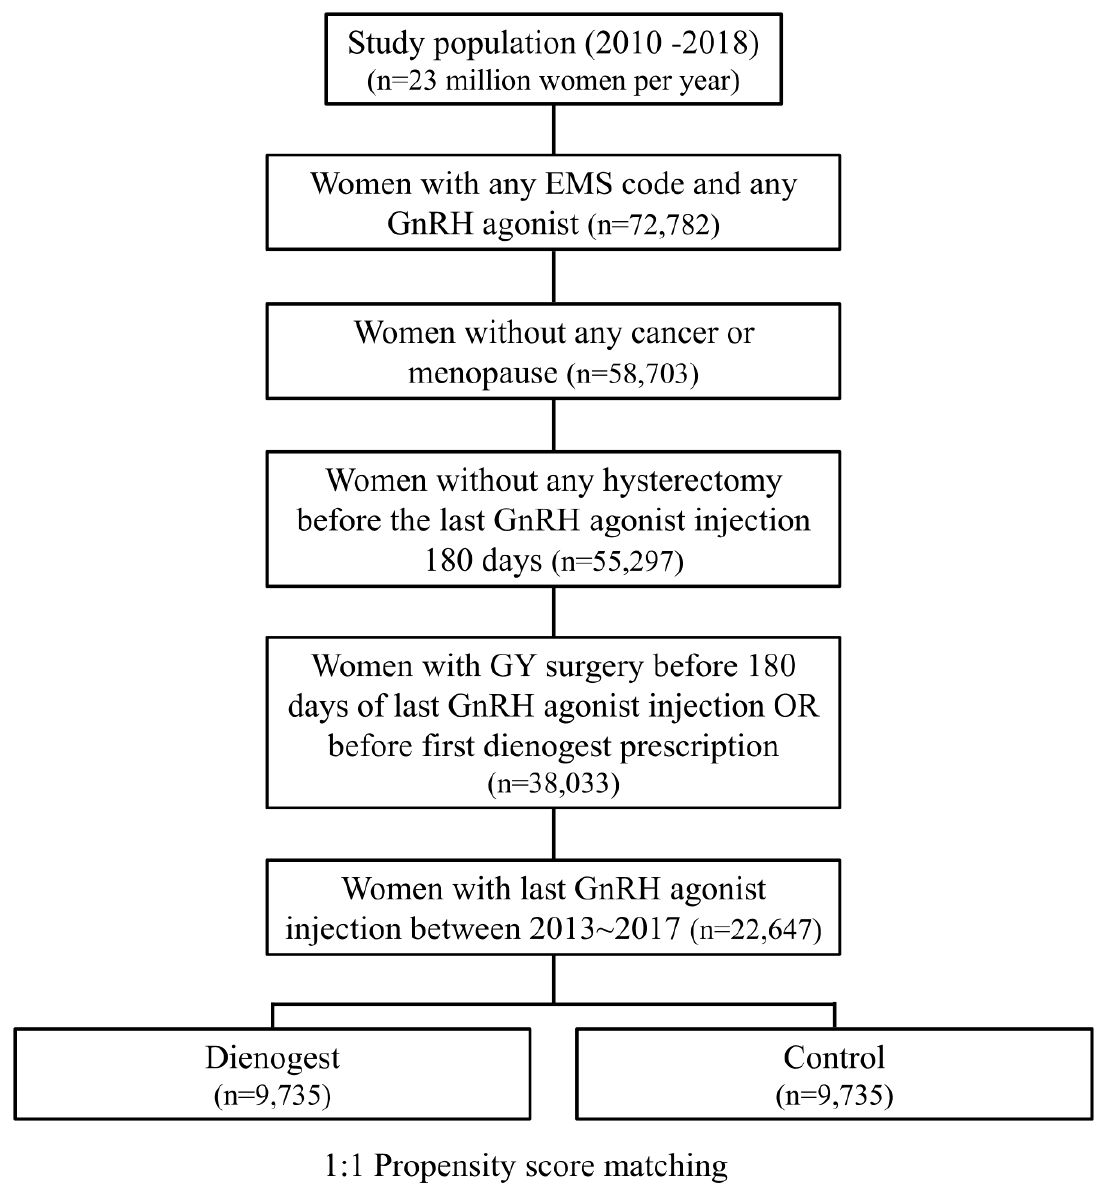
Figure 1. Flowchart to select cases and controls according to DNG use in the HIRA 2010–2018 data. GnRH, gonadotropin- releasing hormone; GY, gynecology; HIRA, The Health Insurance Review and Assessment Service.